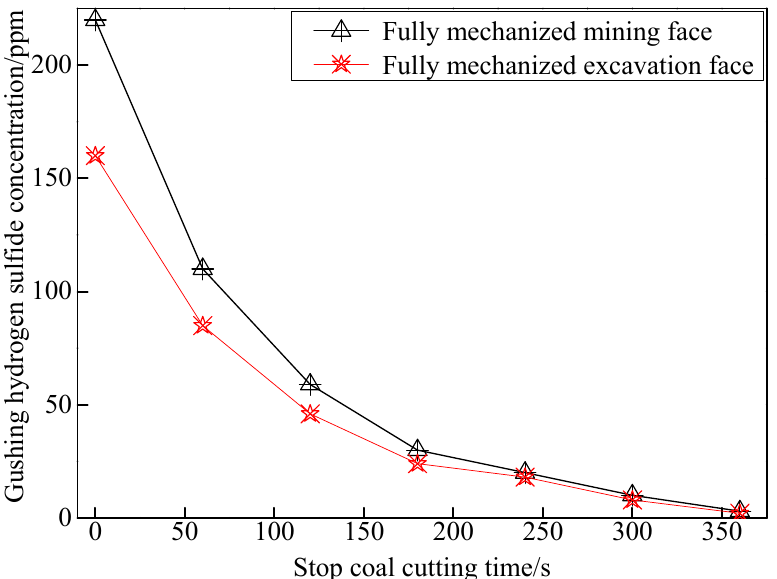
Figure 12. The attenuation law of hydrogen sulfide gushing during the mining process of the working face.